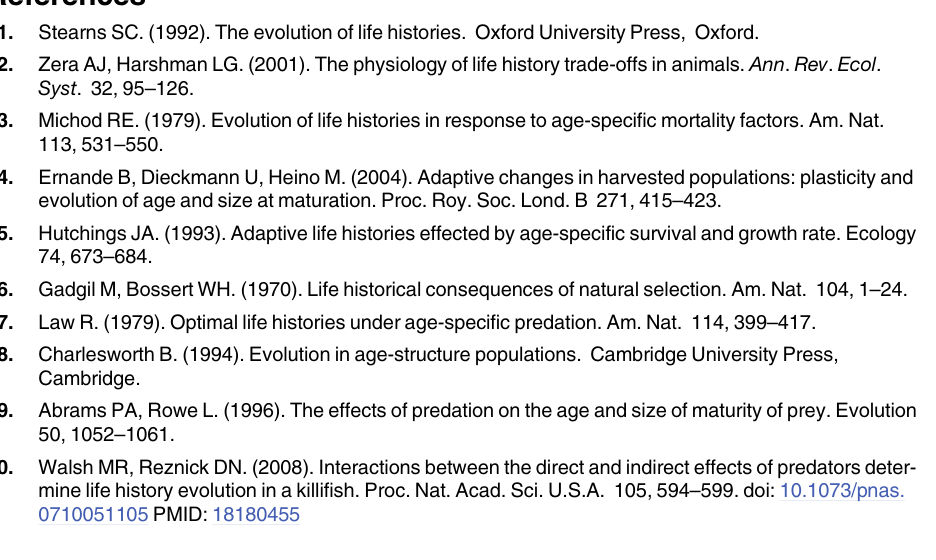
S1 Table. Sample sizes and size range of specimens examined for each